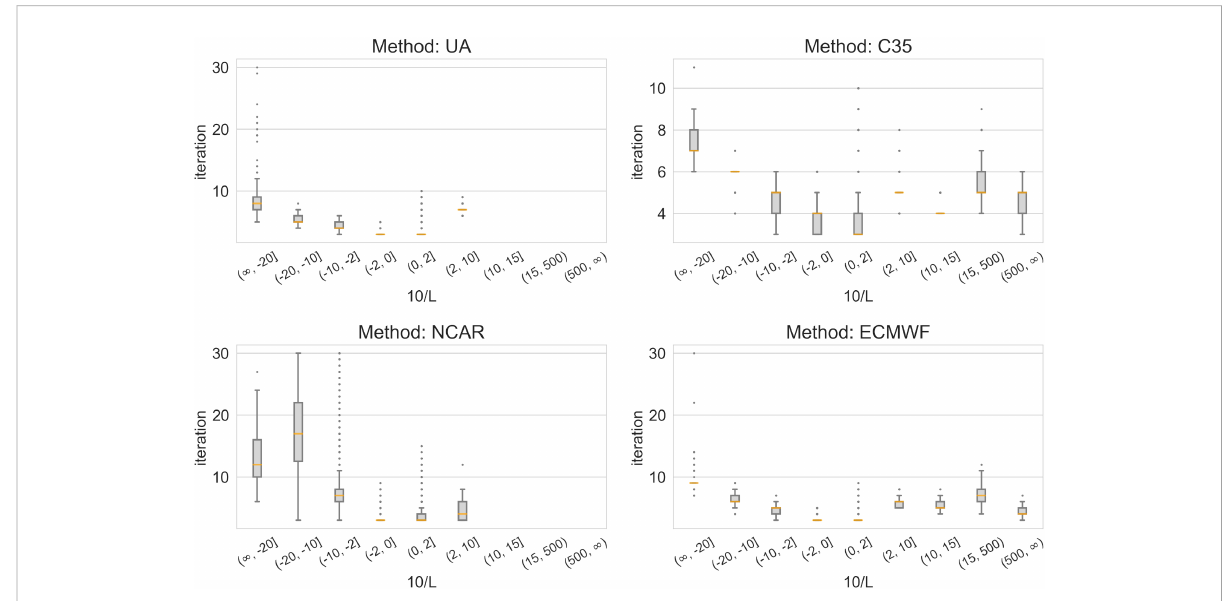
FIGURE 6 Boxplots of the number of iterations needed for convergence (in AirSeaFluxCode) relative to various stability ranges (10/L tsrv ), showing the median (orange line), the inter-quartile range (25 – 75%, box), the outer range (whiskers, < 25% and > 75% respectively). Outliers (0.7% of data) are shown as grey dots. The four parameterizations examined in Section 3.1 are shown. For UA, C35 and ECMWF gustiness is switched on selecting option 1 with b conv =1.2, z i =600 m and u gmin =0.01 ms – 1